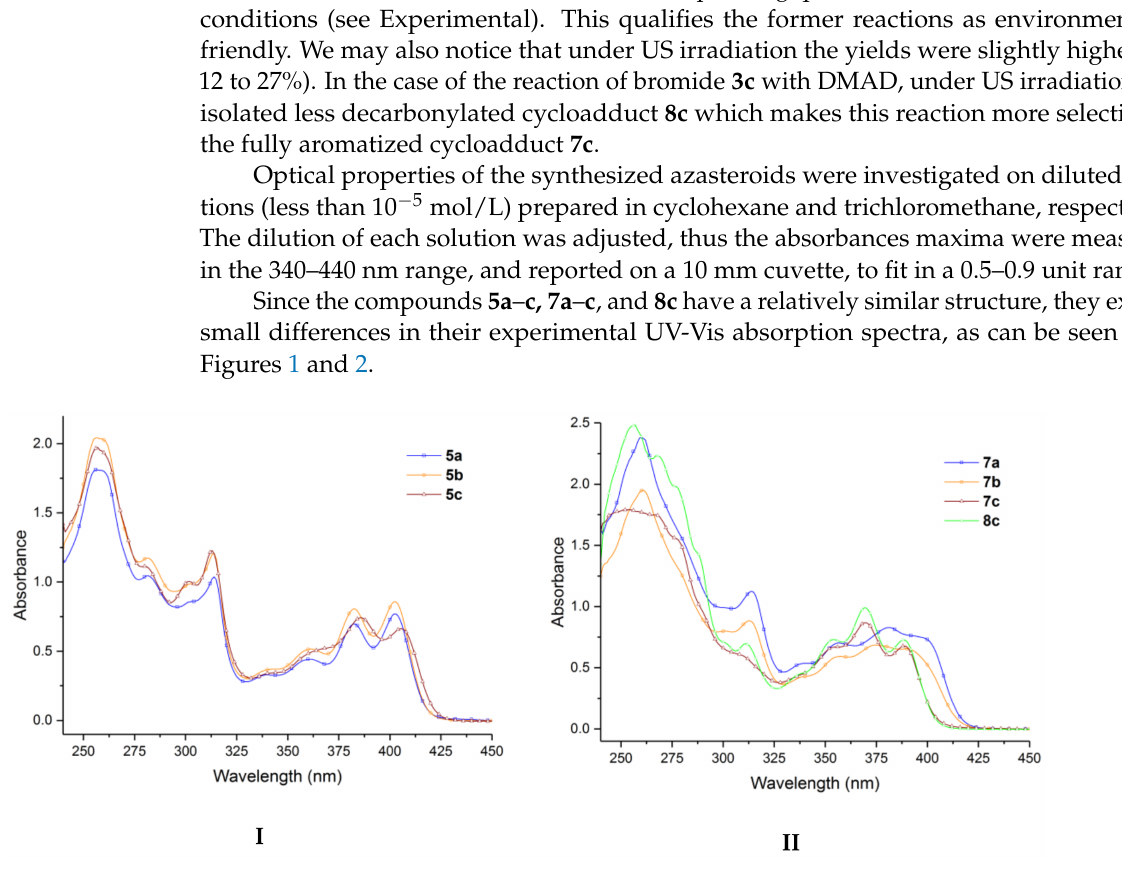
Figure 1. The absorption spectra recorded in trichloromethane solution of the azasteroid derivatives: ( I )- 5a – c ; ( II )- 7a – c , and 8c .